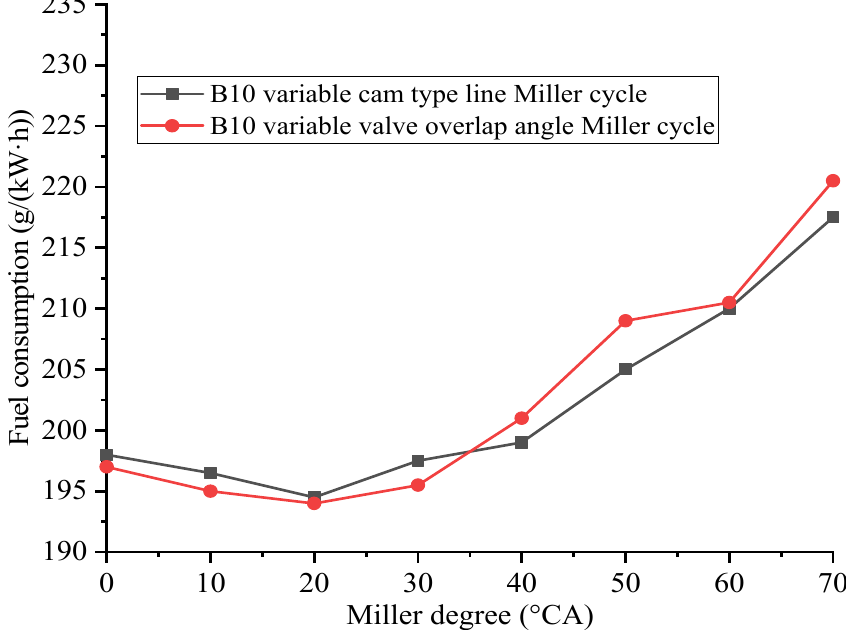
Figure 19. Comparison of fuel consumption of two Miller cycles.